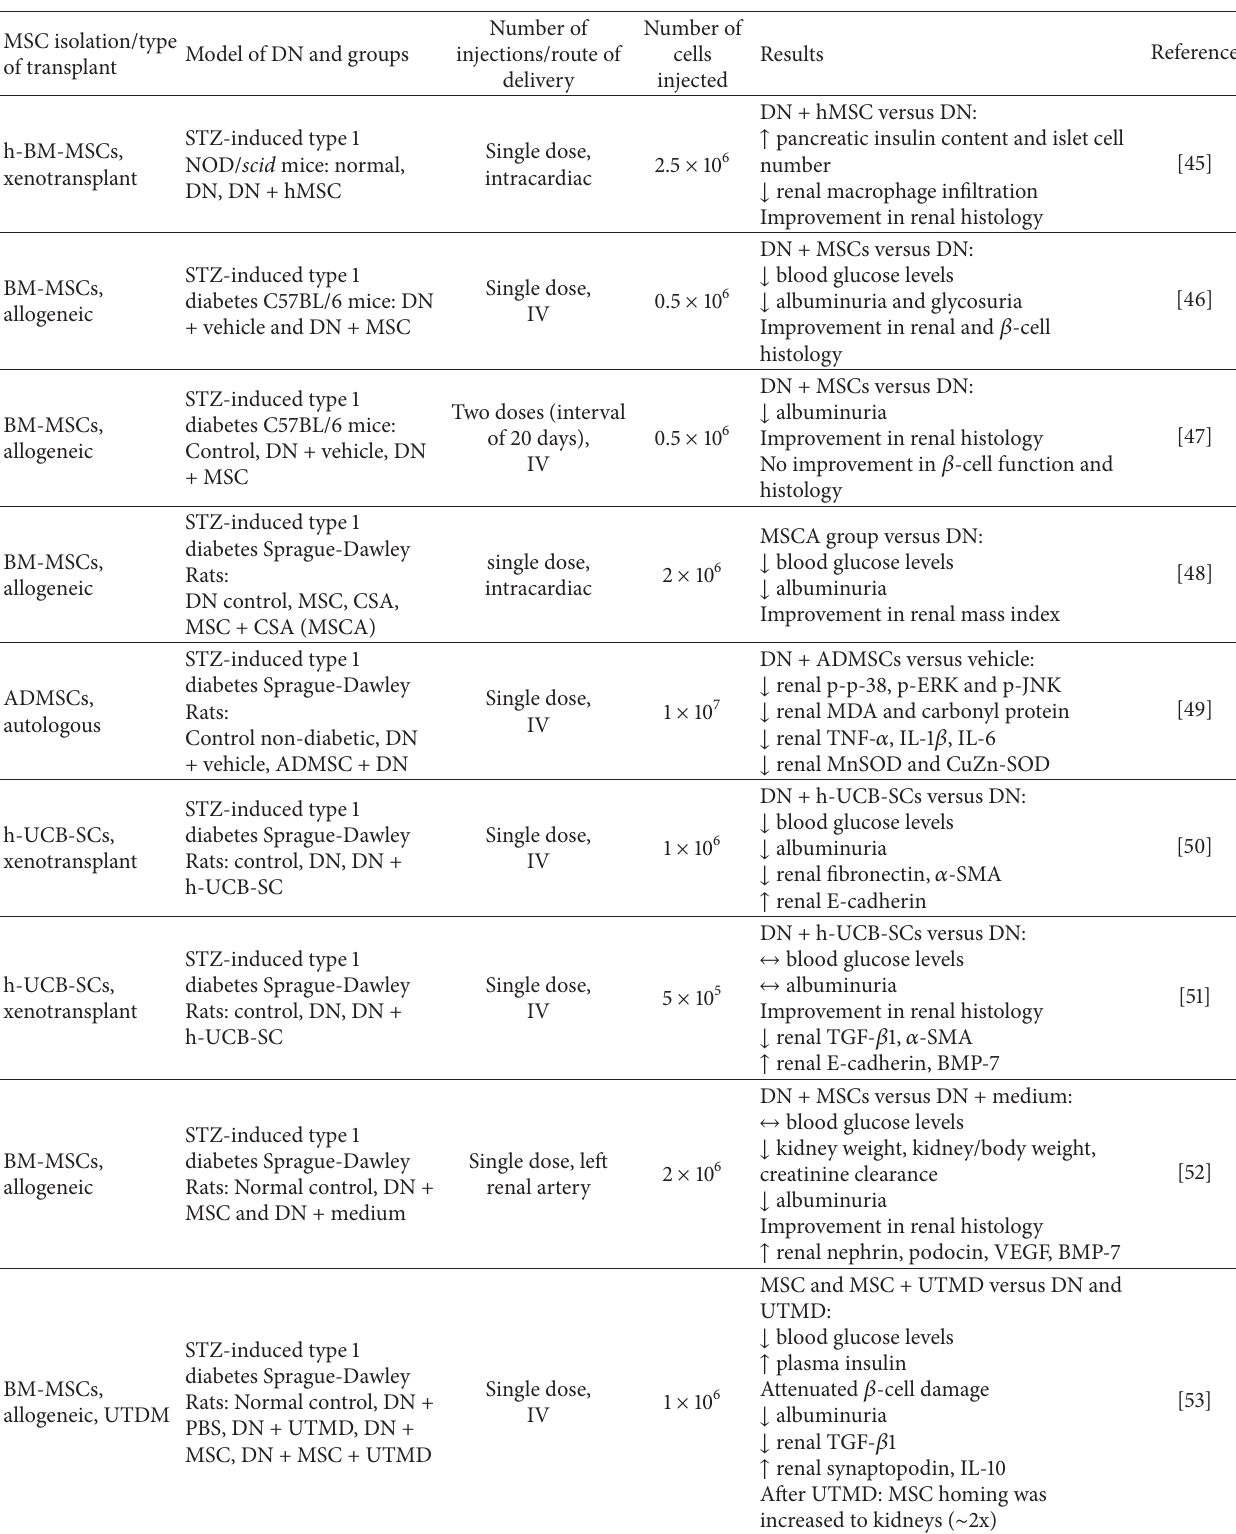
Table 1: Preclinical studies in rodents to test the potential of MSCs in